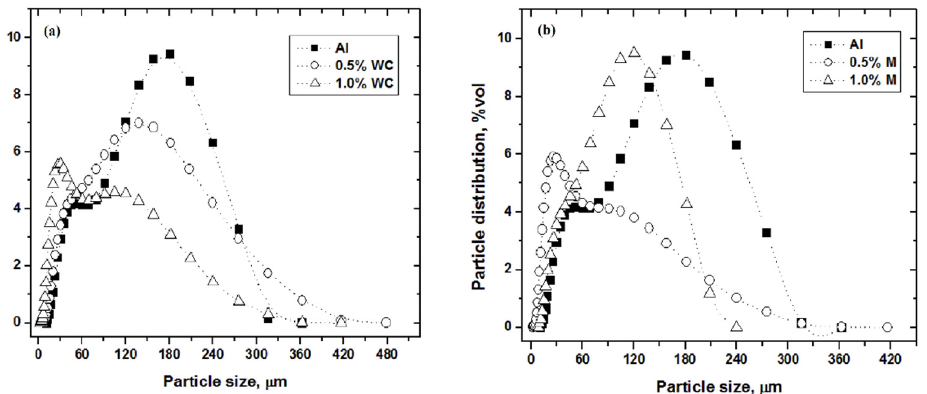
Figure 2. Distribution of particle sizes in powder samples after the grinding stage. ( a ) System with additions of WC, ( b ) System with additions of mullite.